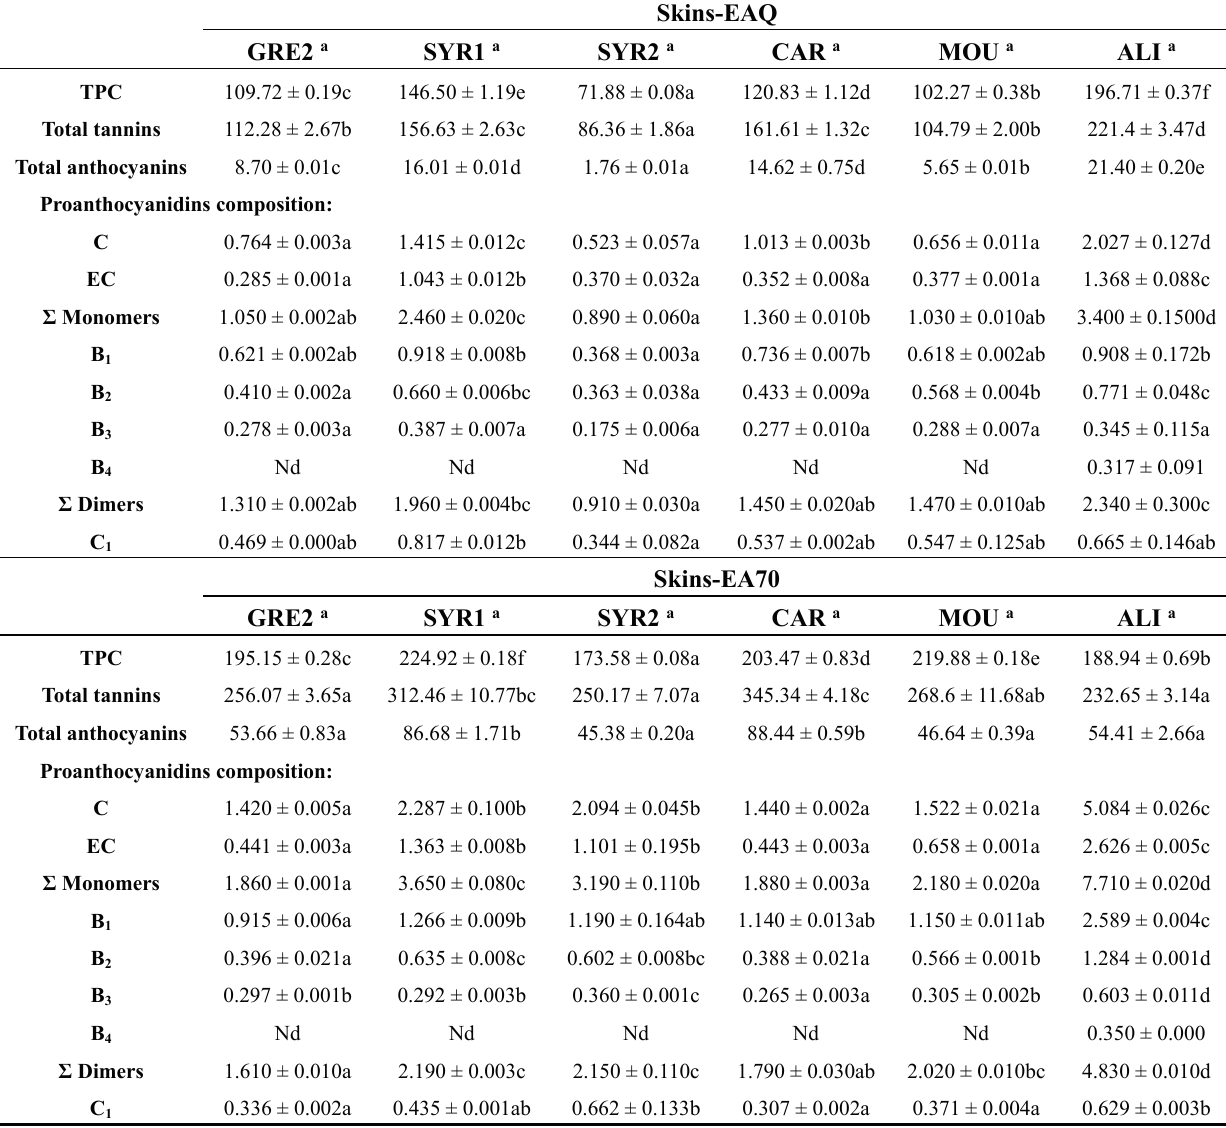
Table 2. Total phenol contents, total tannins, total anthocyanins and flavan-3-ol monomers, dimers and trimer characterisation in EAQ and EA70 grape pomace skin